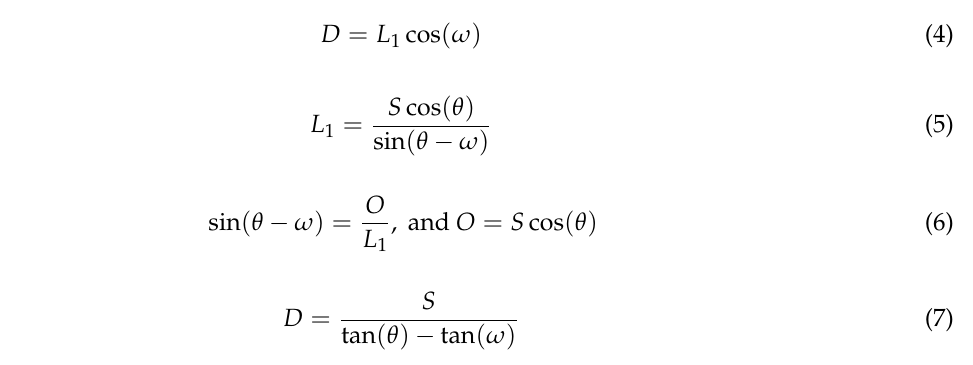
Figure 3. Triangulation geometry principle for a laser scanning